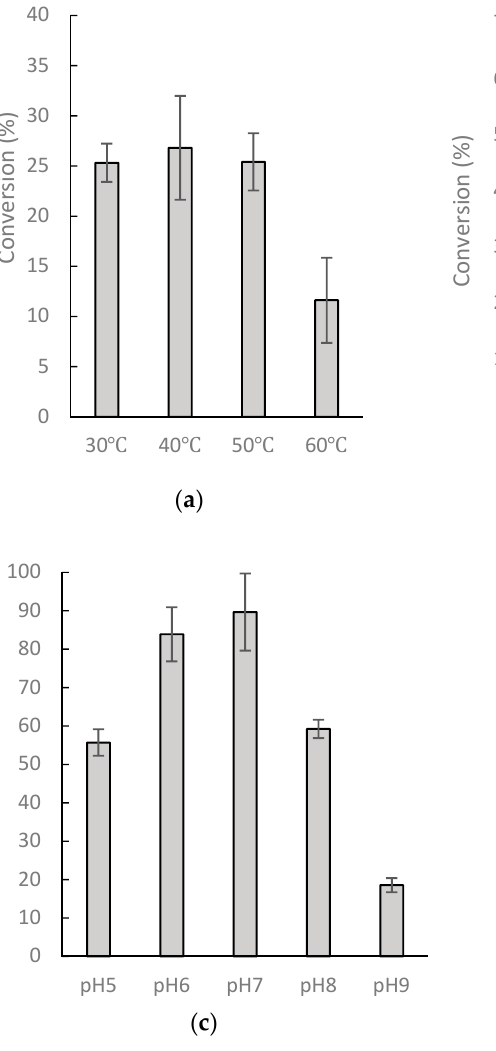
Figure 3. Optimal condition for the production of compound ( 1 ) from 8-OHDe by DgAS. ( a ) 125 µg of the purified DgAS and 1 mg/mL of 8-OHDe were incubated at different temperatures, ( b ) serial concentrations of sucrose, and ( c ) pH levels for 30 min. After incubation, the reaction was analyzed with UPLC. The conversion was calculated by dividing the amount of the produced compound ( 1 ) in each reaction by the theoretical production value (1.6 mg) for 100% conversion. The mean ( n = 3) is shown, and the standard deviations are represented by error bars.